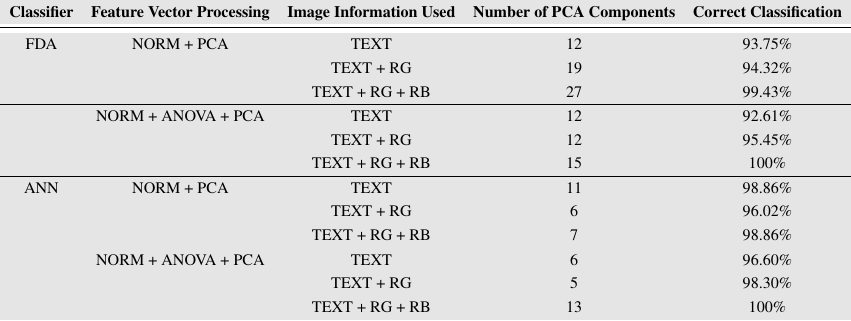
Table 1. Classification results. NORM, normalization; TEXT, textural